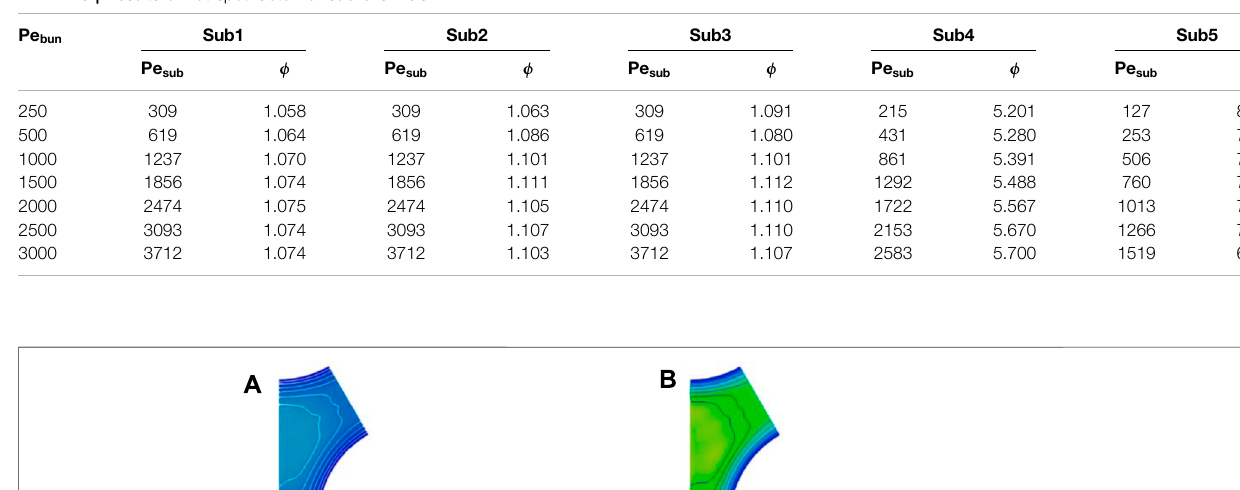
TABLE 8 | Results of hot spot factor for sub-channels.